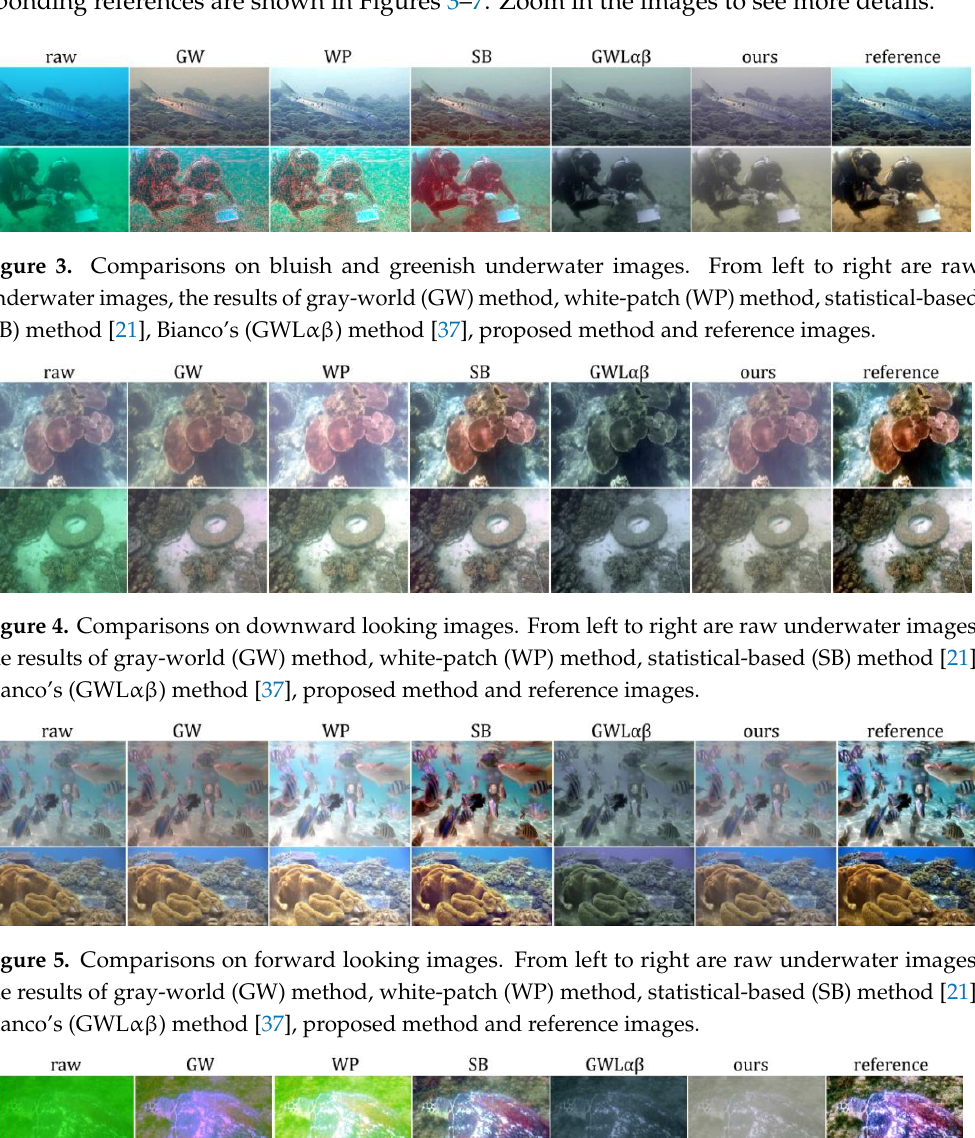
Figure 7. Comparisons on high backscatter scenes. From left to right are raw underwater images, the results of gray-world (GW) method, white-patch (WP) method, statistical-based (SB) method [21], Bianco’s (GWLαβ) method [37], proposed method and reference images. It can be seen from Figures 4 and 5 that the proposed method does not show obvious advantages on the images with little color cast, which is consistent with expectations. From Figure 6, we can see that the proposed method could correct the color cast well though the restored image still does not look very good due to the unimproved contrast. The restored images of the total 890 images with reference images in the UIEB dataset are compared between the test methods. We found the GW, WP and SB [21] methods often cause artifacts, especially in the dark regions of the images with severe color cast, as shown in Figure 8. Bianco’s method [37] often over-grays the images making the color compressed or lost, as shown in Figures 4, 5, and 9. The proposed method has consistently outperformed the other methods on the images with severe color cast. Many restored images obtained by the proposed method look even more natural than the reference images, as shown in Figure 10. Figure 8. Comparisons on images with severe color cast. From left to right are raw underwater images, the results of gray-world (GW) method, white-patch (WP) method, statistical-based (SB) method [21], Bianco’s (GWLαβ) method [37], proposed method and reference images.